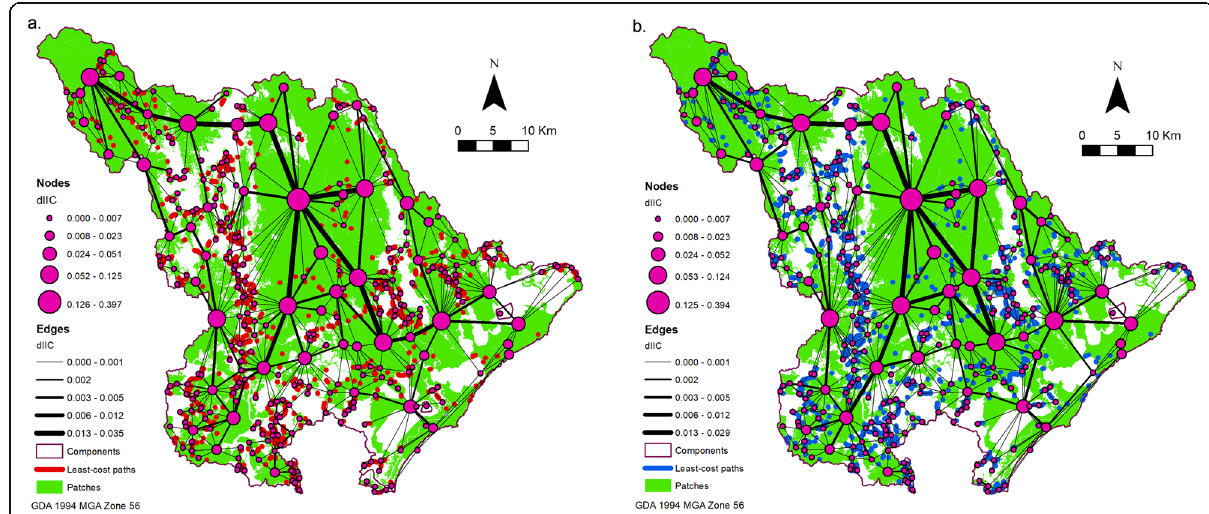
Fig. 4 Patch-scale delta integral index of connectivity (IIC) metric modelled: a with the gap crossing layer characterising movement between scattered trees and b without the gap crossing layer. The importance of linkages and patches is denoted by the thickness of the lines and size of the circles respectively. The circles are located at the centroid of each